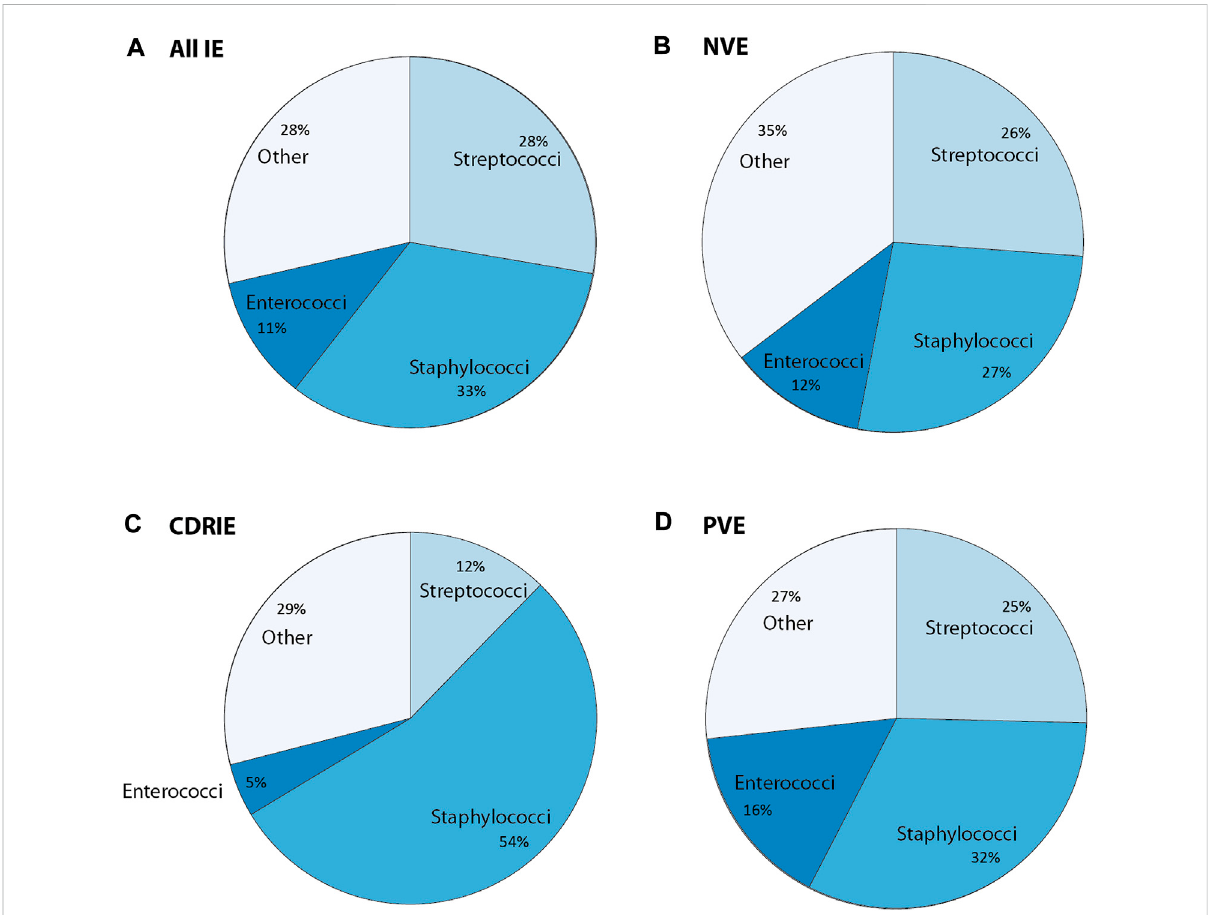
FIGURE 2 Overviewofcausativebacteriaininfectiveendocarditis(IE)concerning (A) allIEcases, (B) nativevalveendocarditis(NVE),and (C) cardiacdevice related-infective endocarditis (CDRIE) that is further subdivided into (D) prosthetic valve endocarditis (PVE). Other refers to either other cultured or unidenti fi ed microorganisms. The values in this graph were obtained using the following references (Cahill and Prendergast, 2016; Wang A. et al., 2018; DeSimone and Sohail, 2018; DeSimone and Sohall, 2018, Babe ș et al., 2021; Doring et al., 2018; Teoh and Hannan, 2018; Slawinski et al., 2019; Mateos Gaitán et al., 2020; Khalil and Sou fi ,